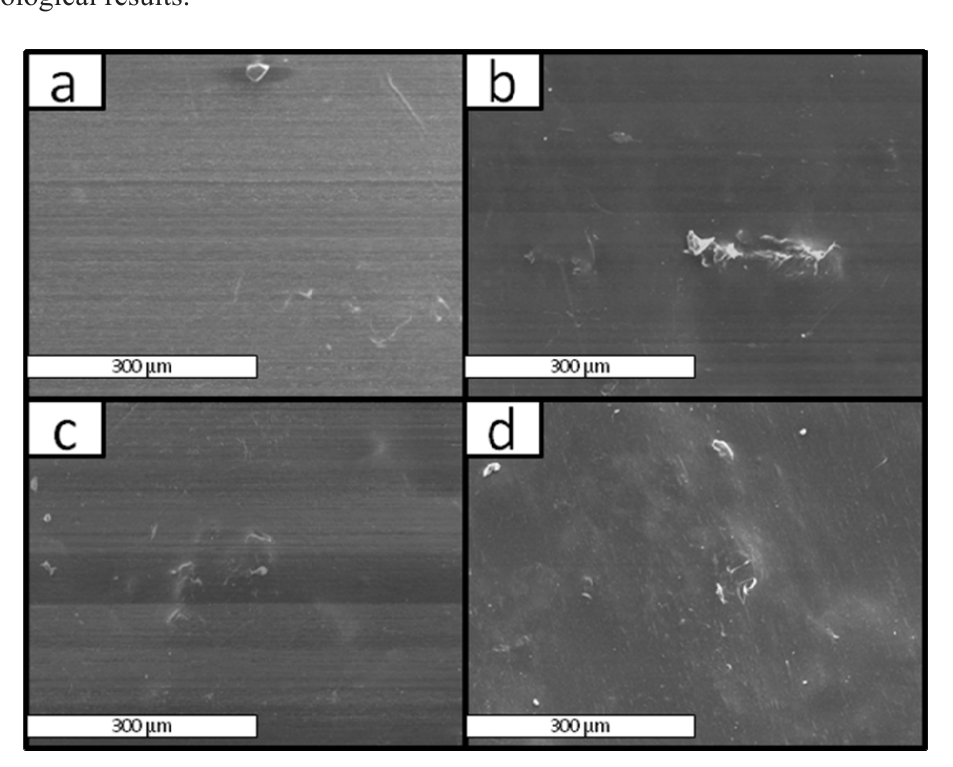
Figure 7. SEM micrographs of the surface of films ( a ) H1, ( b ) I1, ( c ) H4 and ( d )